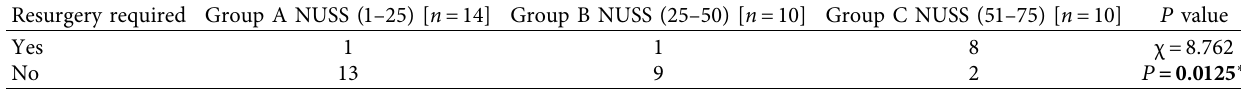
Table 6: Patients requiring resurgery.